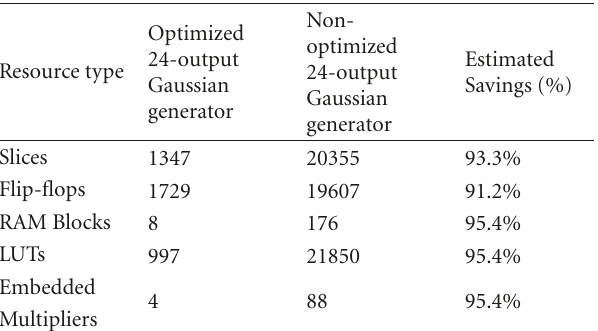
Table 3: Estimated savings due to optimizing the Gaussian